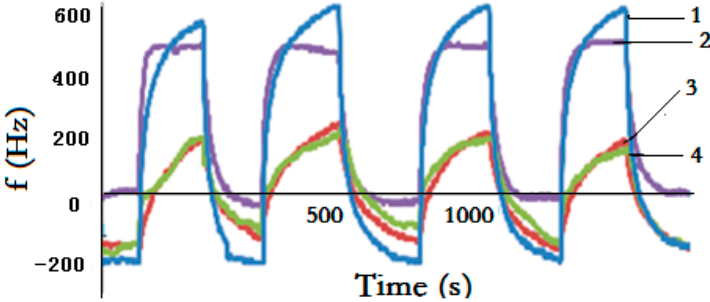
Figure 4. Four times responses and repeatability of sensor array to H 2 S. (1—sensor 1, 2—sensor 2, 3—sensor 3, 4—sensor 4).